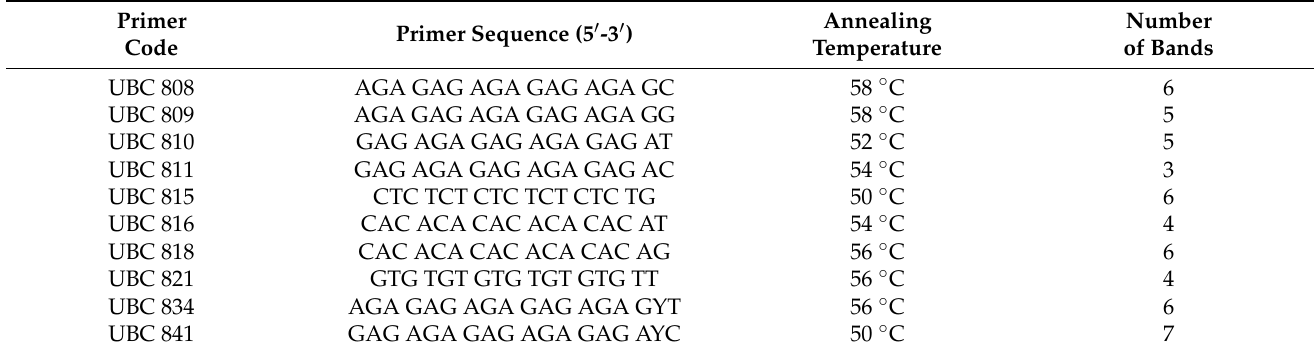
Table 5. Code and sequence of 10 ISSR primers used to determine the genetic stability of G. jasminoides plantlets produced from encapsulated and cold-stored shoot tip explants.